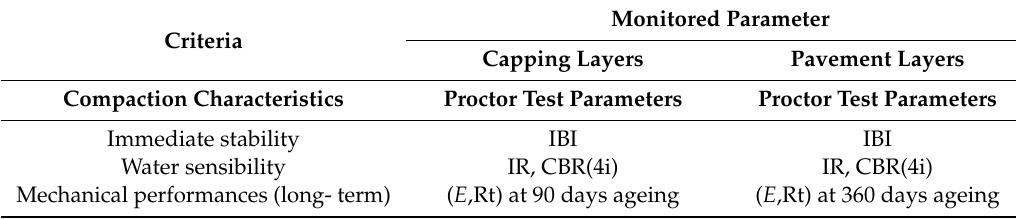
Table 3. Design criteria and quality monitoring parameters for pavement